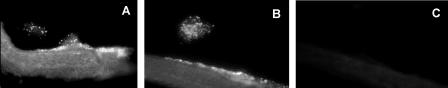
Immunofluorescence Showing Co-Localization of H. influenzae and S. pneumoniae in the Murine NasopharynxBALB/c SCID mice were co-colonized with Hi636 and Sp1121, and at 24 h post-inoculation adjacent 5-μm frozen parasagittal tissue sections through the lateral nasal spaces of the same animals were stained with anti-capsular polysaccharide serum specific to type b H. influenzae (A), type 23F S. pneumoniae (B), or secondary antibody control with no primary antibody (C). Magnification, 400×.